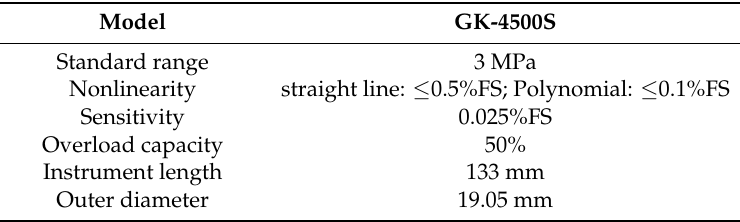
Table 1. Main technical indicators of GK-4500S.